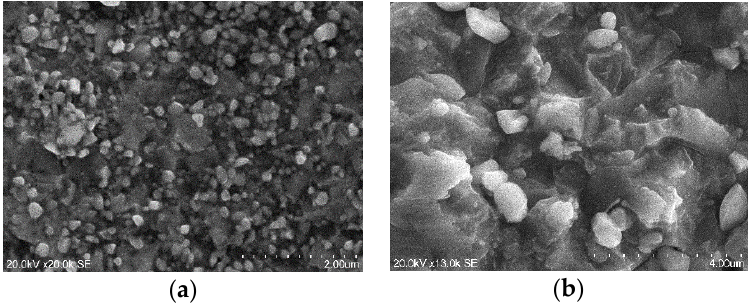
Figure 9. The structures of the Co-Ni-Nb alloys before ( a ) and after ( b ) superplastic deformation at